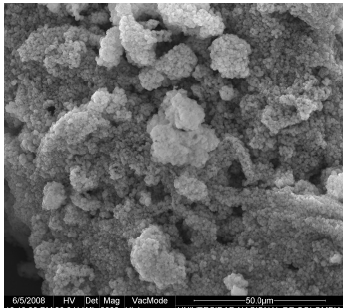
Figure 7. Scanning electron microscopy of the sieve obtained from sample 3 (Zoom 2000X).